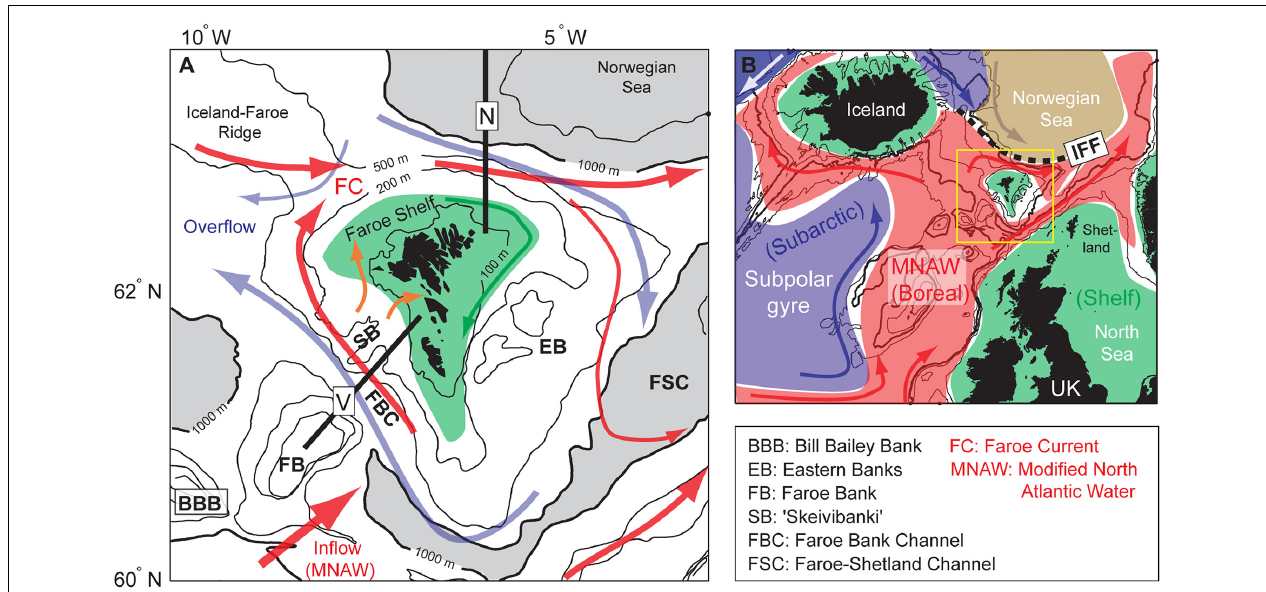
FIGURE 1 | Overview over (A) the Faroe shelf study region and (B) the broader surroundings, colored by the main biogeographic zones ( subarctic- blue , boreal- red and shelves- green). The yellow square in panel (B) outlines the domain in panel (A) , and the black dashed line represents the Iceland-Faroe Front (IFF). Red arrows indicate relatively warm Atlantic currents and blue arrows show cold currents, which in panel (A) are comprised of deep overflows. The green arrow in panel (A) represents the clockwise central shelf circulation, while the orange arrows illustrate the main onto-shelf flows. Locations of two standard hydrographic transects (Sections N and V) are shown with black lines. The 100, 200, 500, 1,000 and, 2,000 m depth contours are shown in panel (A) , and the deepest regions ( > 1,000 m) are gray